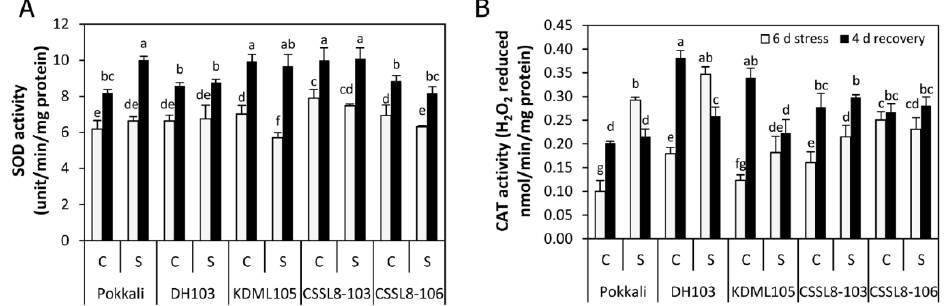
Figure 6. Antioxidant enzyme activities ( A ) Superoxide dismutase (SOD) and ( B ) Catalase (CAT) of rice plants under control and salt stress for 6 days (light gray bars) and after recovery for 4 days (black bars). C, control; S, salt stress. For a description of the genotypes, see Figure 1. Values are means of four replications ± SE. Different letters indicate a significant difference in the means of each group ( p ≤